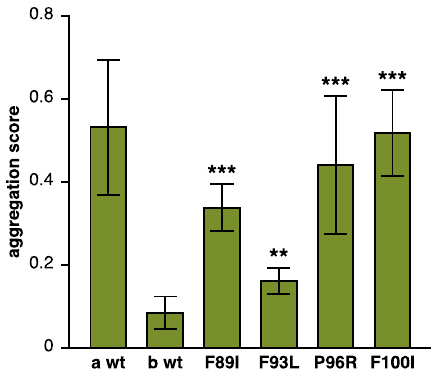
Figure 3. Loss of antiaggregation effect due to DNAJB6 mutations. Various DNAJB6b constructs were tested in a filter trap assay for their ability to prevent the aggregation of polyQ huntingtin. Similarly to the previously tested p.F89I and p.F93L, both p.P96R and p.F100I mutations showed impaired antiaggregation activity. Wild-type DNAJB6a (a wt) and DNAJB6b (b wt) serve as negative and positive controls, respectively. The graph shows mean ± S.D. of eight to nine replicate transfections from three separate experiments. Asterisks indicate statistically significant differences to b wt according to the Mann–Whitney U test (** p < 0.01, *** p < 0.001).